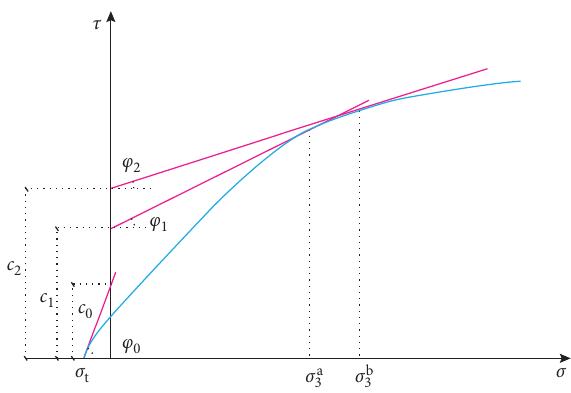
Figure 1: The envelope of the H-B yield criterion in the Mohr diagram and the parameters.